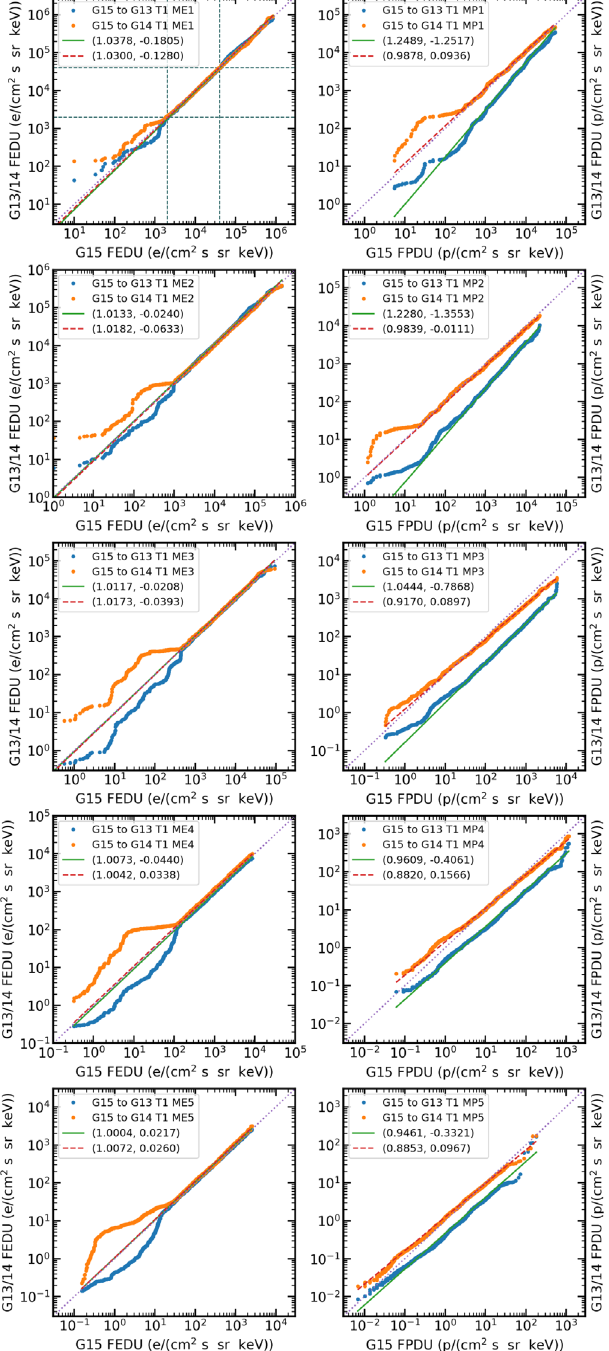
Fig. 5. Statistical asynchronous regressions (SAR) of GOES-15 mapped to GOES-13 and -14 particle fl uxes during July 2010. The left column shows the results for the MAGED Telescope 1 ME1- ME5 channels. The right column shows the results for the MAGPD Telescope 1 MP1-MP5 channels. The dotted diagonal line represents the identity relationship. The results of the Theil-Sen fi ts to the mappings are described in the legends by a pair of numbers representing the fi rst- and zeroth-order terms of a linear fi t to log10 ( fl ux). FEDU = differential unidirectional electron fl ux. FPDU = dif- ferential unidirectional proton fl